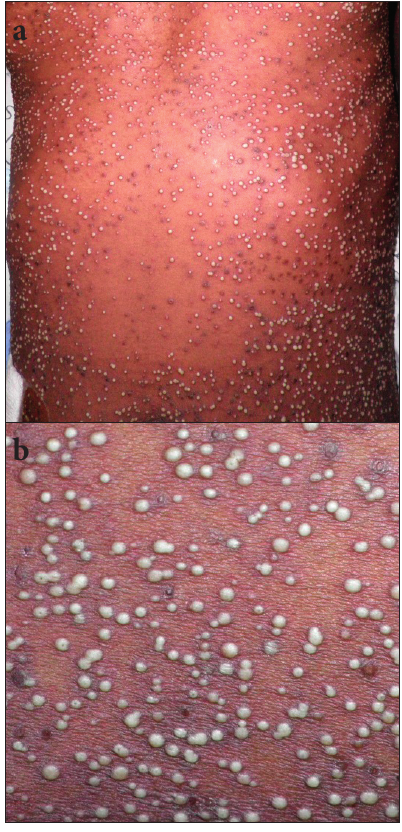
Fig. 1(a and b). Acute generalised exanthematous